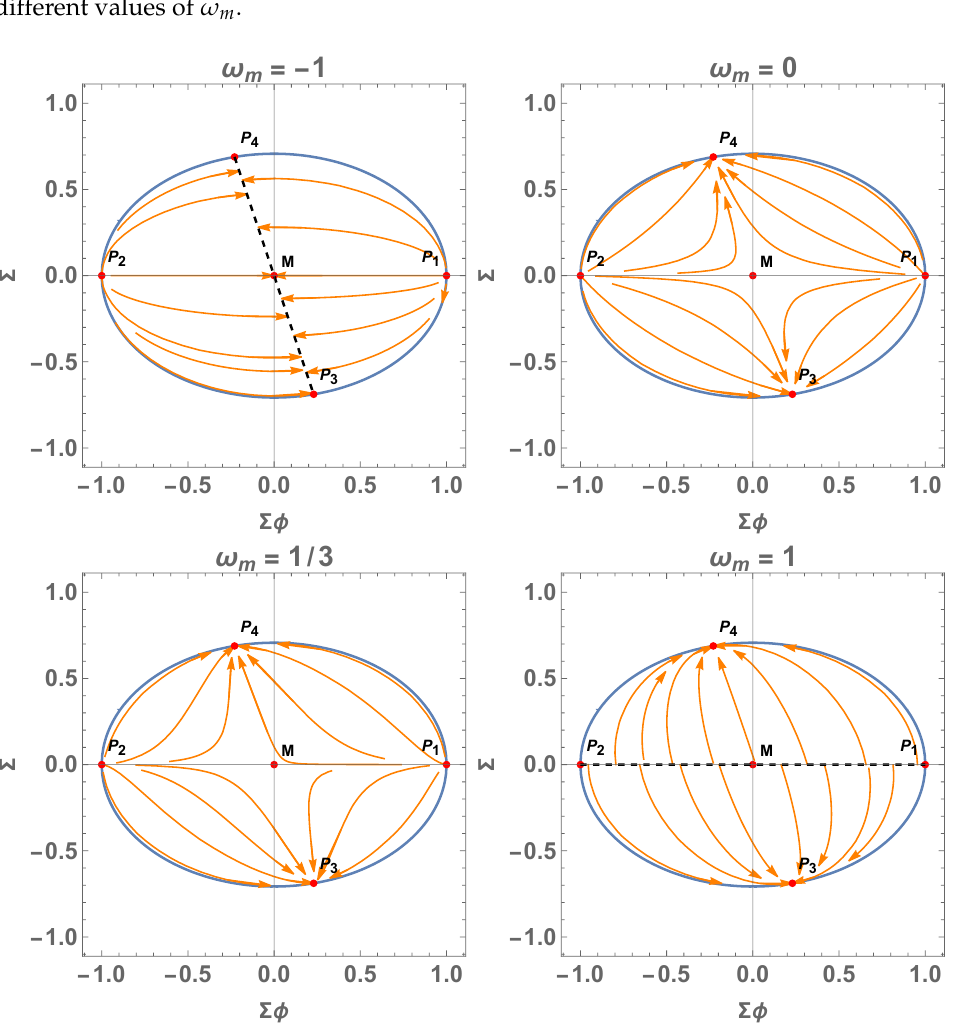
Figure 7. The 2D projections of the system (85)–(86) for (cid:101) = + 1, µ = 2, and different values of ω m